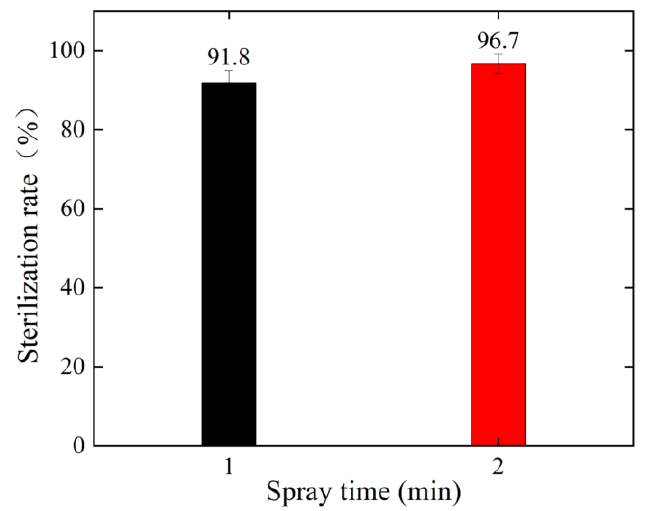
Figure 12. Disinfection effect of atomized PATW on clothing surface.